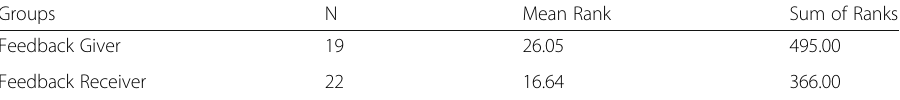
Table 8 Feedback giver group and feedback receiver group ranks in the picture description task Groups